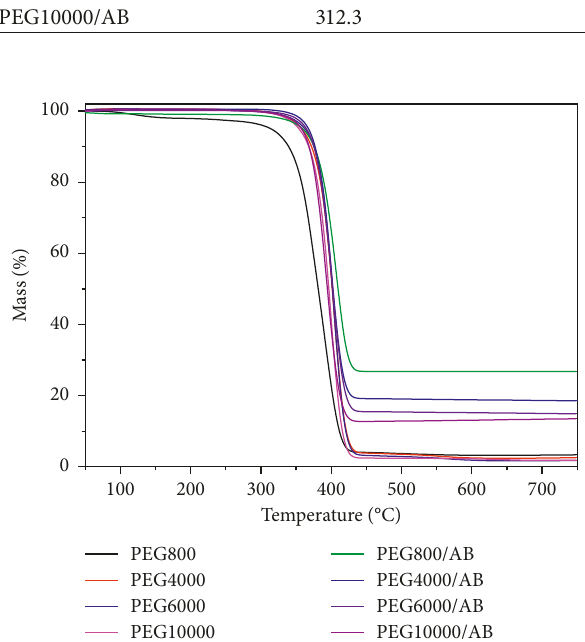
Figure 4: TG plots of the PEGs and PEG/AB composites.